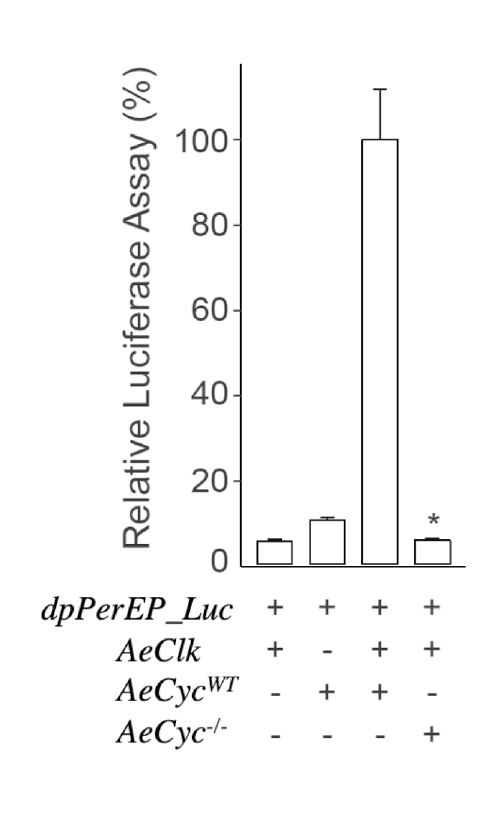
Figure 3. The mutant AeCyc lacking the PAS and transactivation domains is impaired in transcriptional activation in S2 cells. The monarch per E box luciferase reporter (dpPerEp_Luc; 10 ng) was used in presence (+) or absence (–) of wildtype AeClk , AeCyc WT , AeCyc −/− expression plasmids (5 ng each). Firefly luciferase activity was computed relative to renilla luciferase activity. Each value is mean ± SEM of three replicates. One-way ANOVA, AeCLK:AeCYC −/− vs. AeCLK:AeCYC WT , * p ≤